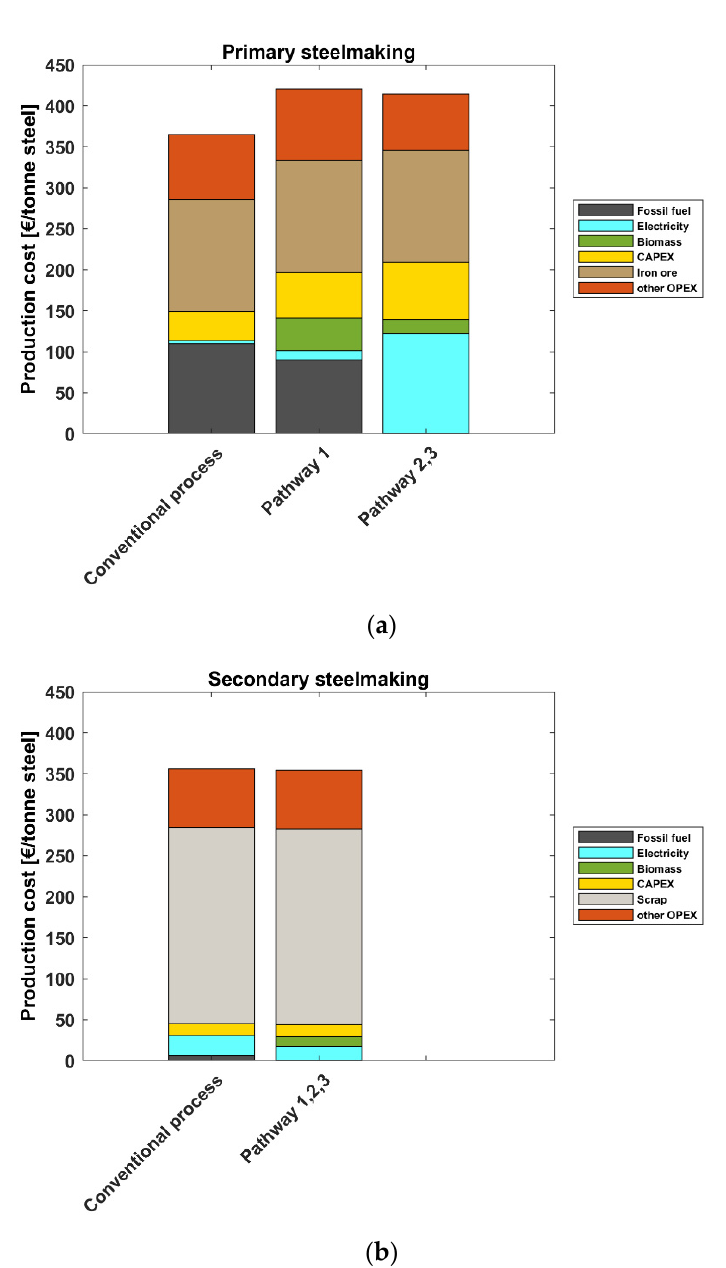
Figure 4. Steel production cost for primary steelmaking technologies ( a ) and secondary steelmaking technologies ( b ) applied in the pathways investigated in this work.